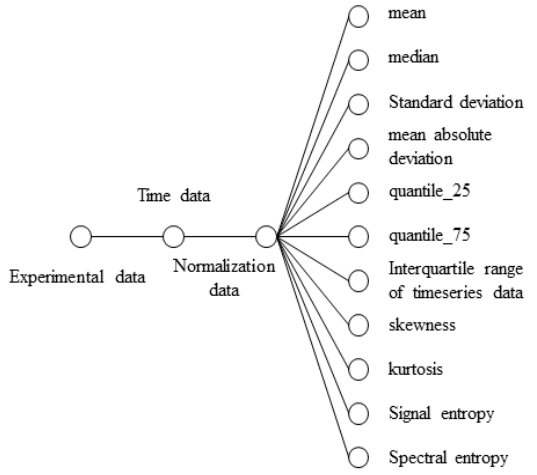
Figure 9. Features extracted from time series of experimental data.